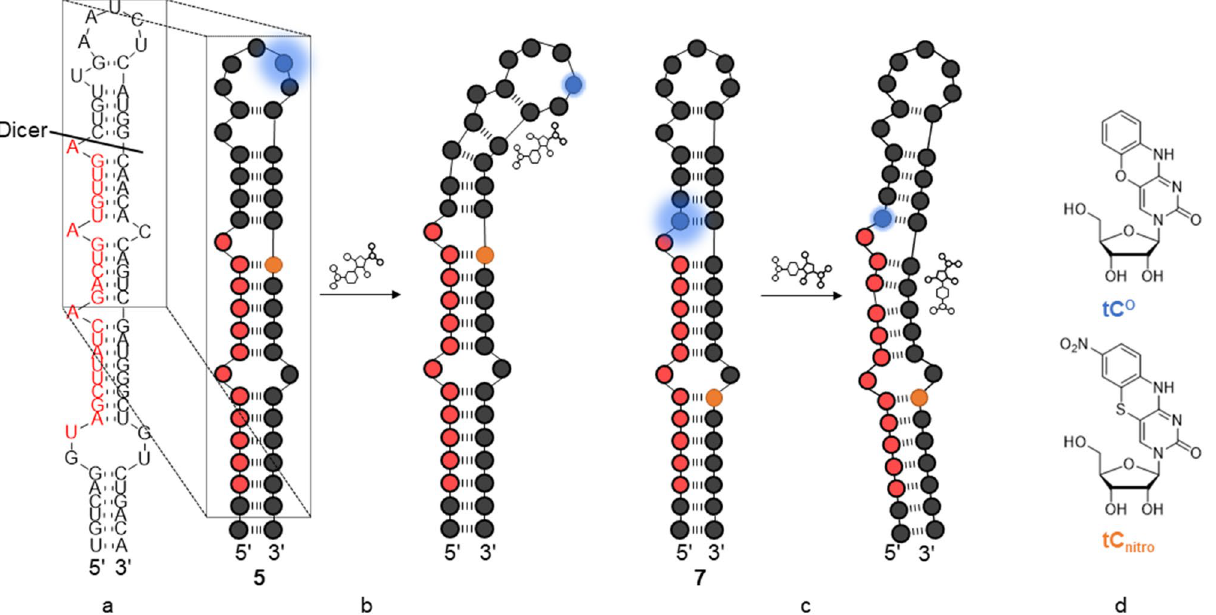
Figure 1. Design of the interbase-FRET assay. ( a ) The full-length pre-miR-21 ( 1 ) with miR-21 sequence in red and Dicer cleavage sites marked by the black line. ( b ) Ligand binding to the hairpin loop region of FRET- labelled pre-miR-21 construct ( 5 , Table 1) causes a distance and/or orientation change between the fluorescent FRET donor (blue) and the non-fluorescent FRET acceptor (orange), thereby changing the FRET efficiency, and consequently, either an increase or a decrease in emission is observed. ( c ) Ligand binding to the stem FRET- labelled pre-miR-21 construct ( 7 , Table 1). ( d ) The chemical structures of the fluorescent FRET donor tC O (blue) and the non-fluorescent FRET acceptor tC nitro (orange).